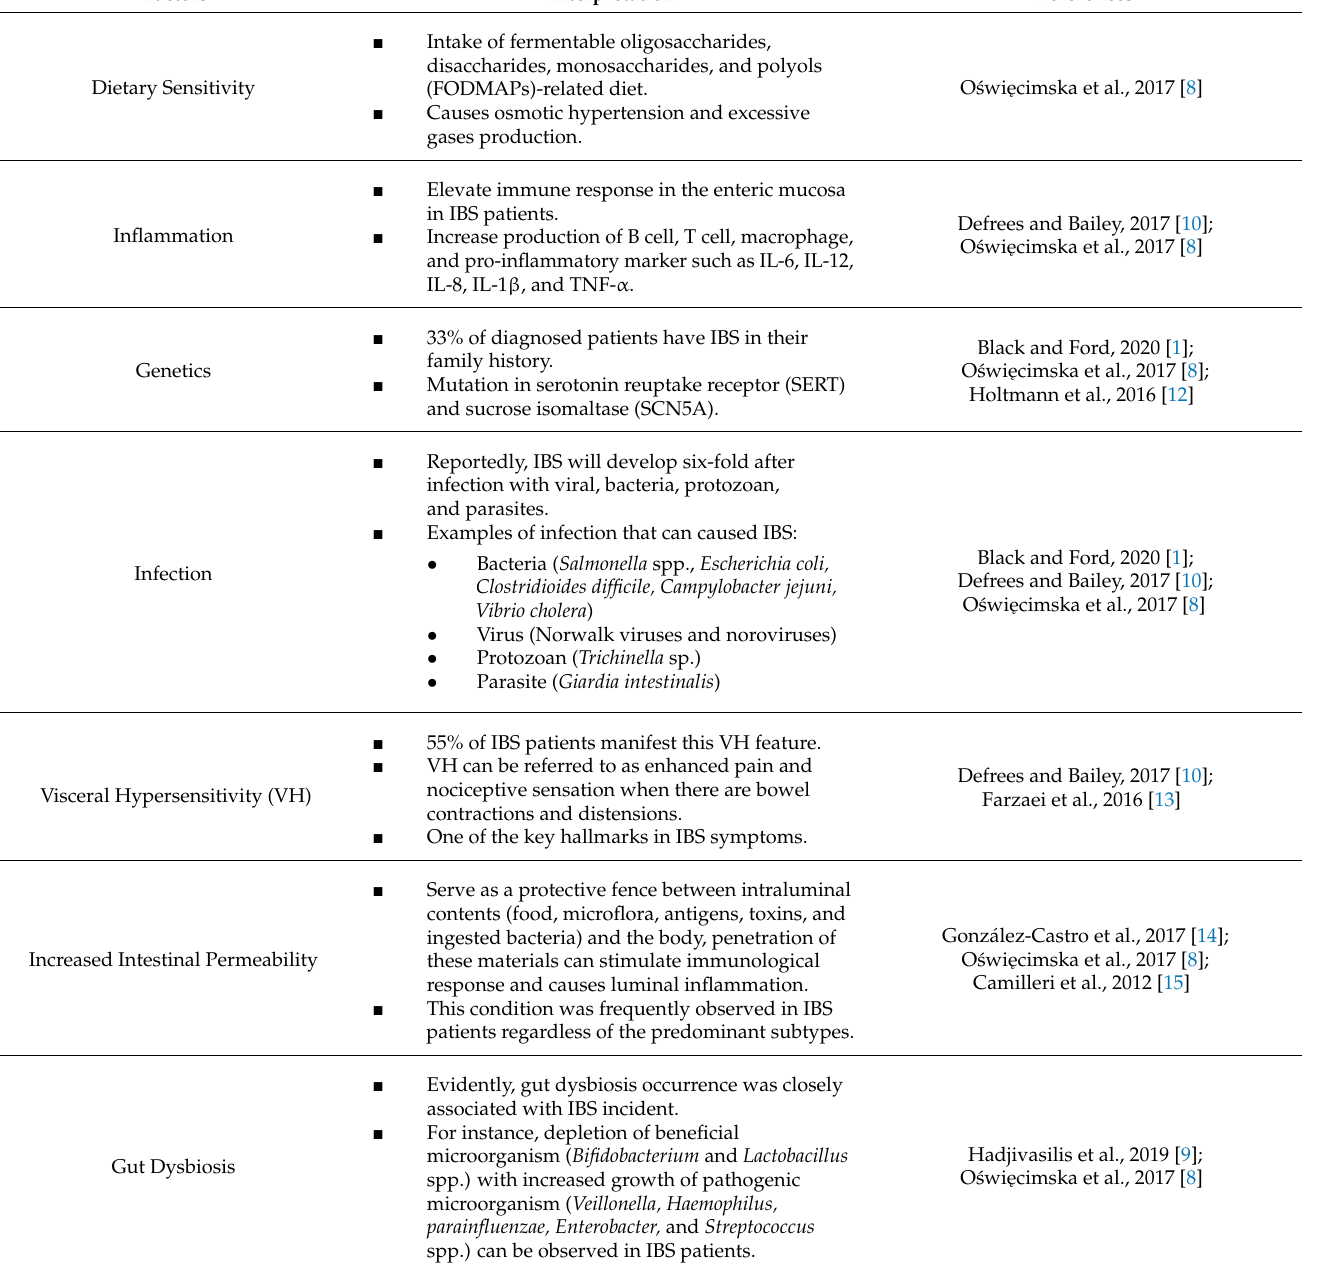
Table 1. Brief summary of pathophysiology that are known to cause irritable bowel syndrome. Factors